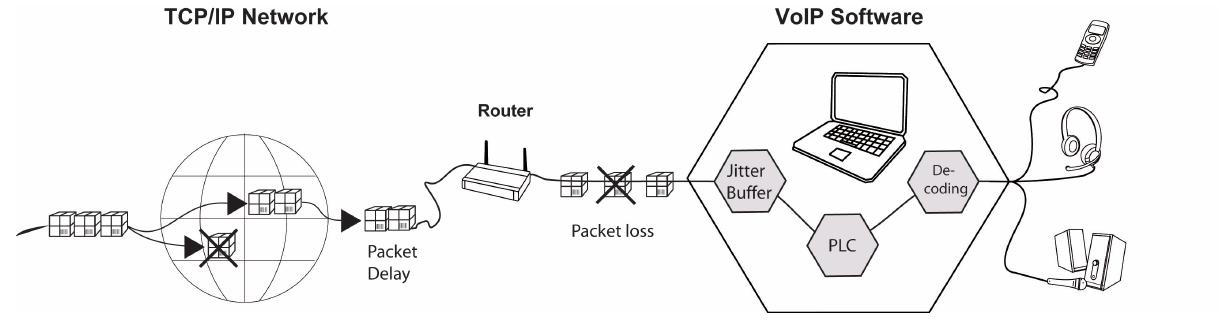
Figure 1. Each data packet originating in a voice over Internet protocol (VoIP)-sending device (not shown) takes a different route through the Internet (TCP/IP network) before arriving at the receiver. Data packets may be delayed or lost on the way. The VoIP software includes two solutions to improve audio quality in these cases: the jitter buffer collects the maximum number of data packets by waiting as long as needed and keeping the time delay to a minimum; and packet loss concealment (PLC) aims to reconstruct lost data packets. Finally, digital data packets are decoded and delivered to a VoIP-compatible user interface, such as a VoIP handheld telephone, a headset, or external